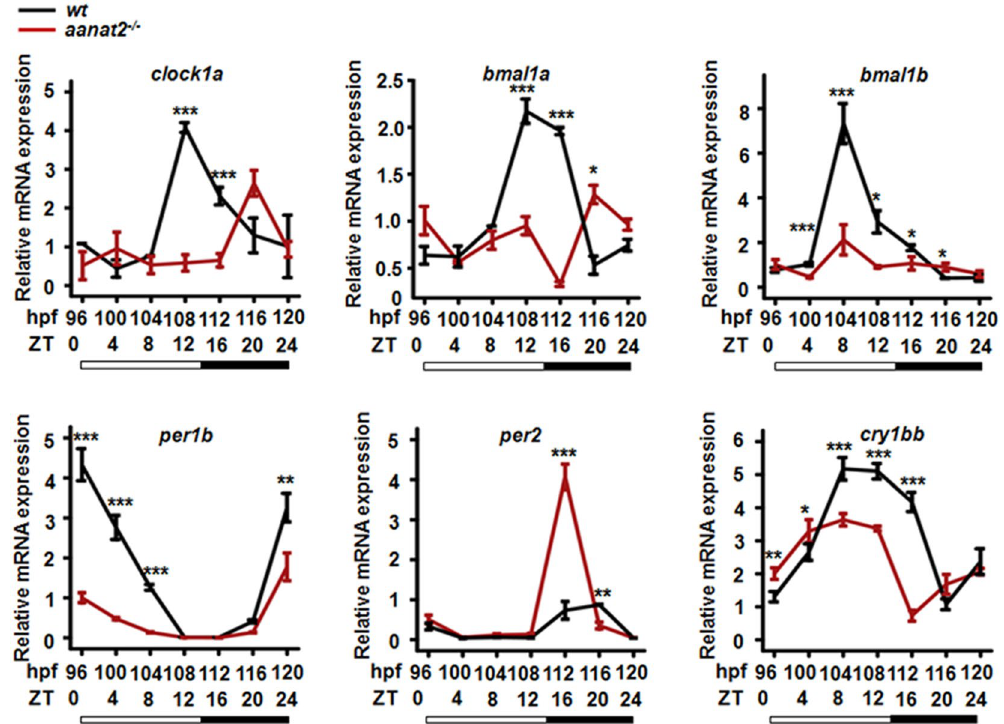
Figure 4. Disrupted expression of circadian clock genes in aanat2 − / − fish. Total RNAs were extracted from wild-type and aanat2 mutant larvae at 4-h intervals for a total of consecutive 24 h under LD. One experiment contains three samples (control = 3, mutant = 3). Each sample contained 50 larvae. The data were analyzed from three samples in both the control and mutant groups. The experiment was repeated three times. ( A – F ) qRT-PCR analysis showed that Rhythmic expression patterns of key circadian clock genes, clock1a , bmal1a , bmal1b , per1a , per1b , and cry1bb were all disrupted in aanat2 mutant larvae. The amplitude of the per1b gene was reduced and the oscillation pattern of the cry1bb gene was phase shifted. The genes were relative expression to β -actin (ANOVA analysis). ( * P < 0.05, ** P < 0.01, *** P <